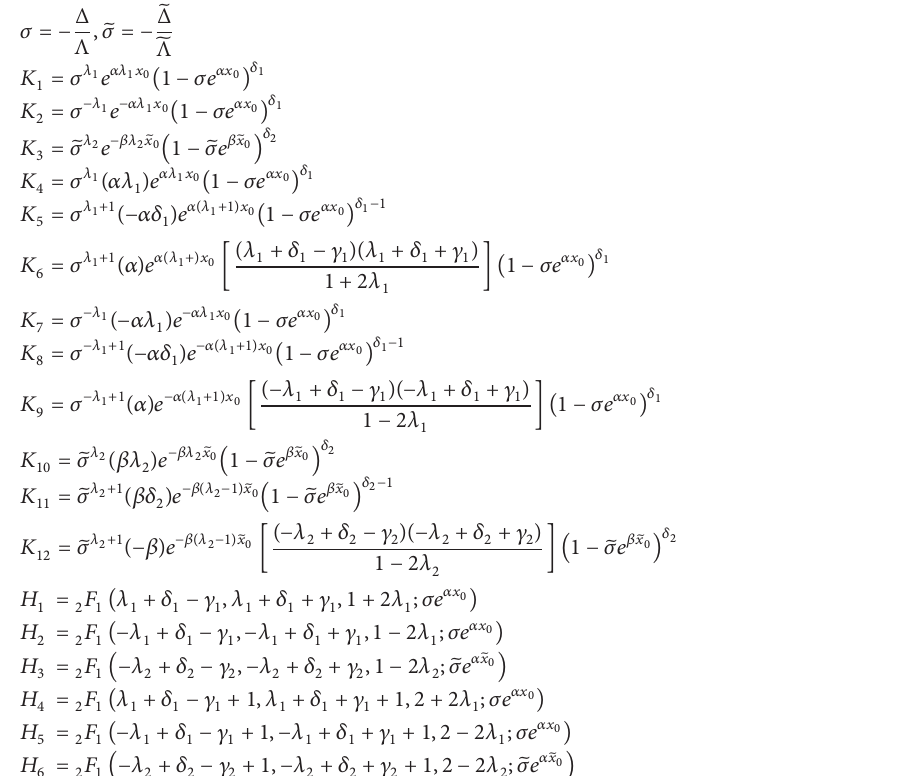
Table 2: The abbreviations defined in the calculations for the scattering